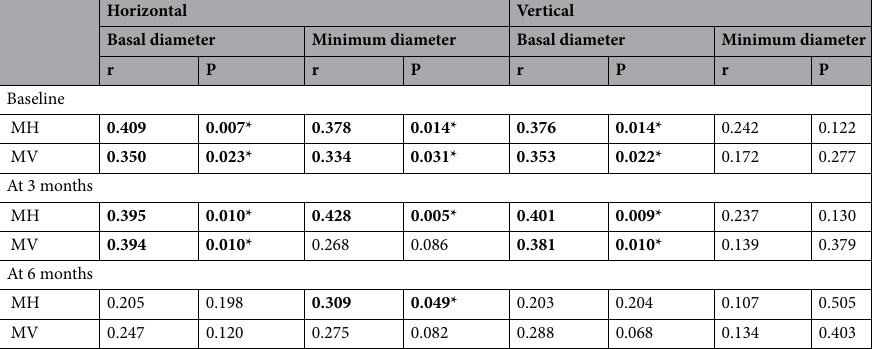
Table 1. Correlations of pre- and postoperative M-CHARTS score with the horizontal and vertical diameter of the macular hole. Spearman’s rank correlation coefficient was used to determine the significance of the correlations. MH horizontal score of M-CHARTS, MV vertical score of M-CHARTS. Significant P value are indicated by asterisk (*). Significant values are in bold.